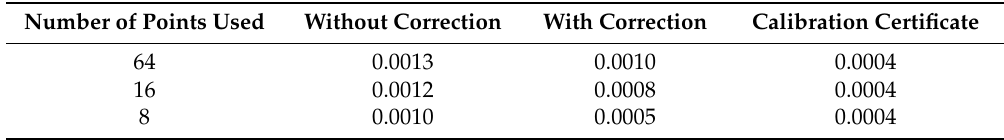
Table 2. Results of roundness deviation measurements (given in mm) for standard ring with and without probe head errors